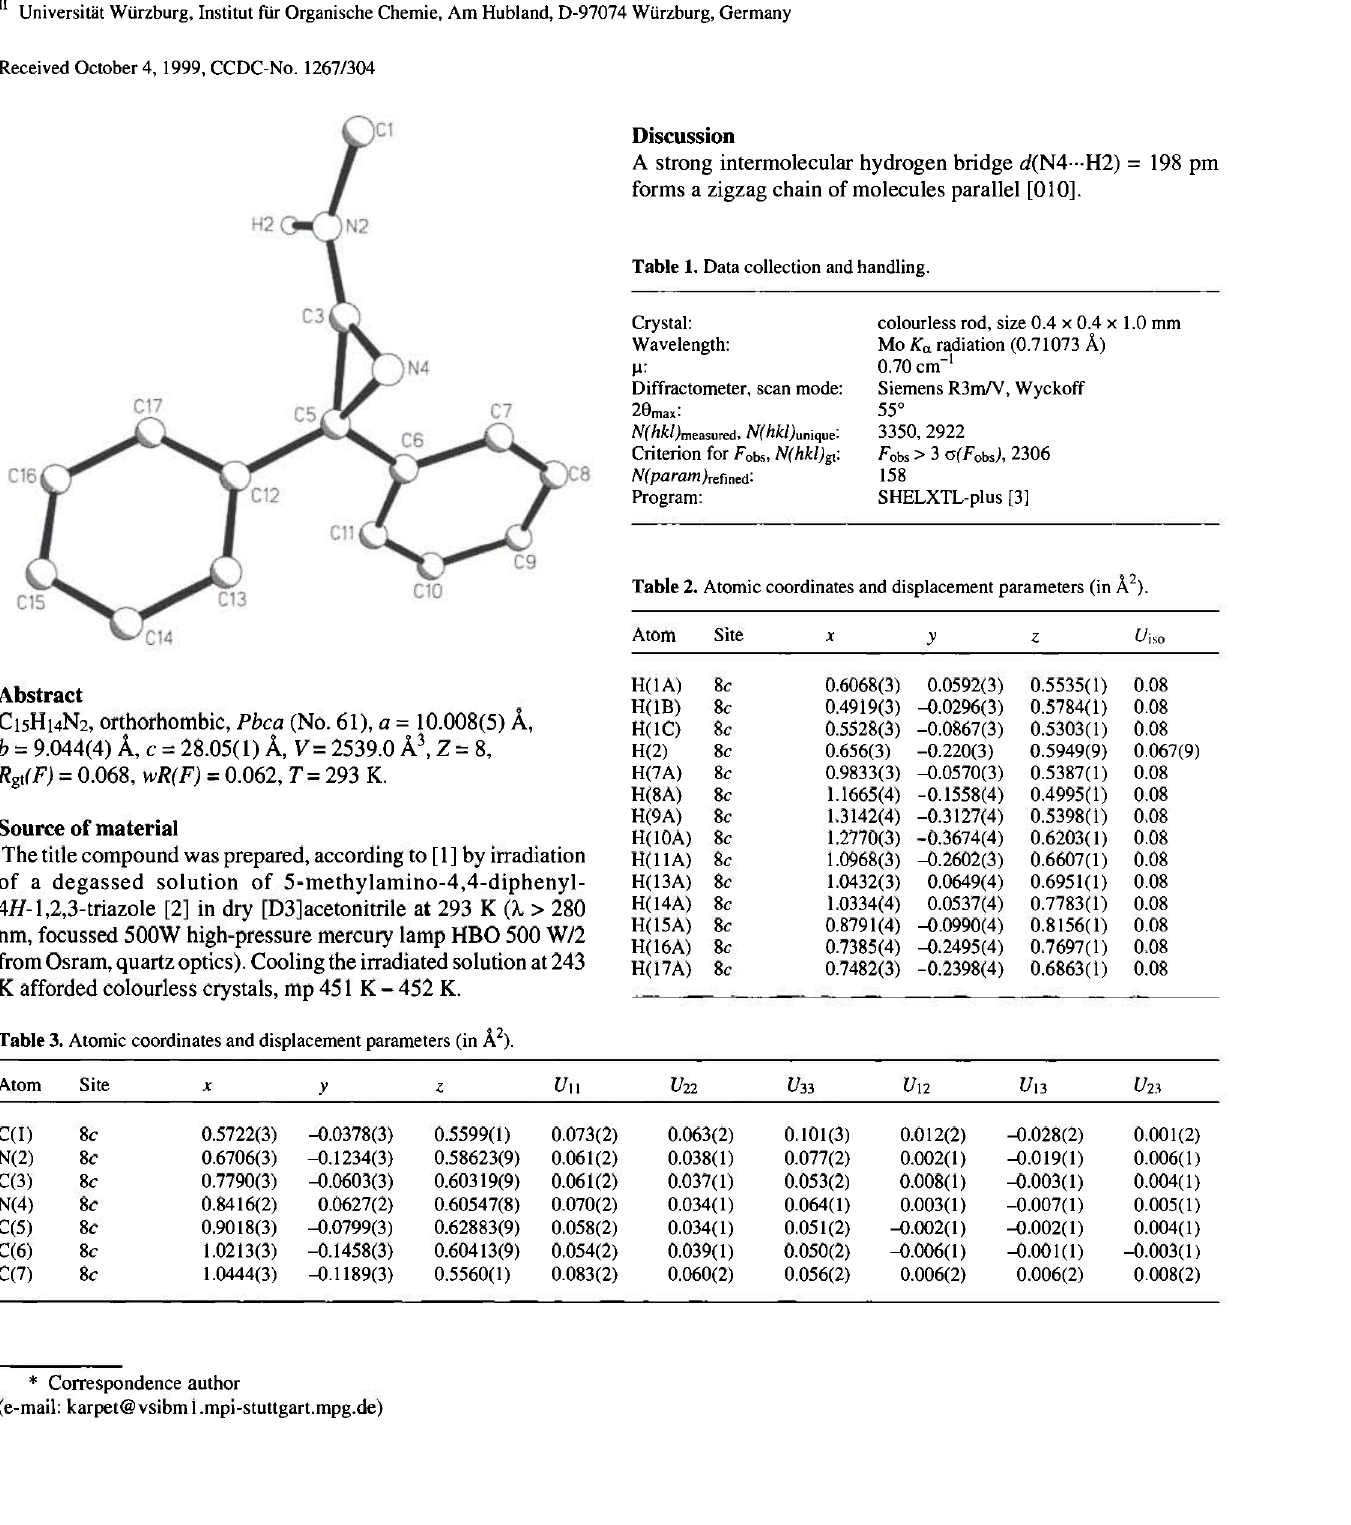
Table 1. Data collection and handling.